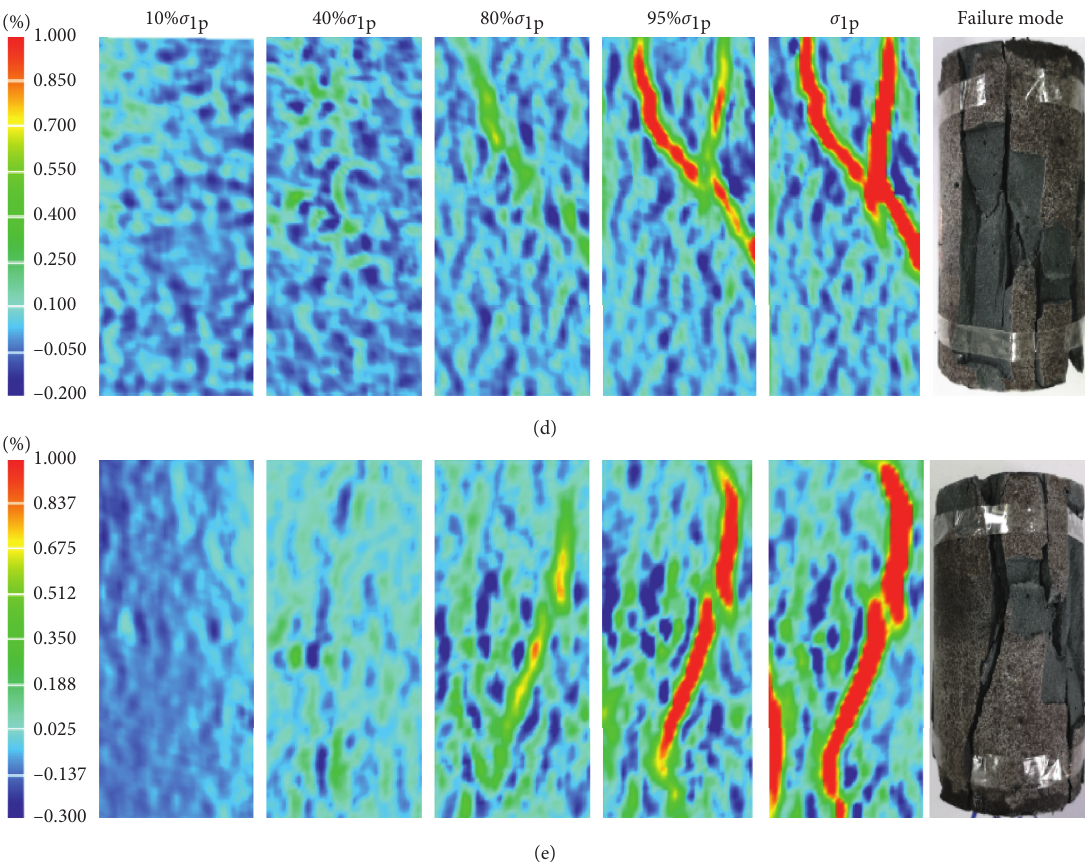
Figure 12: Evolution process of strain fields of specimens containing closed 3D-printing rough joints with different joint lengths under uniaxial compression ( α � 60 ° ). (a) Specimen S1-1# ( l � 20.0mm). (b) Specimen S2-1# ( l � 27.1 mm). (c) Specimen S3-2# ( l � 30.6mm). (d) Specimen S4-1# ( l � 35.6 mm). (e) Specimen T60-2# ( l �